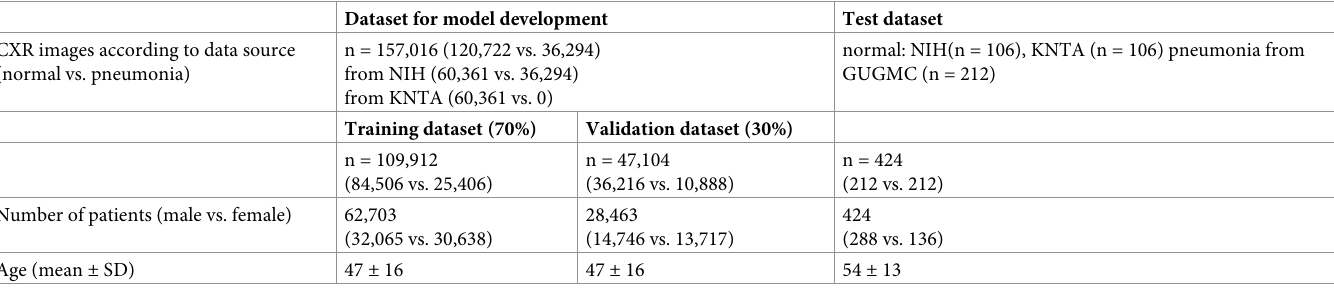
Table 1. Dataset for model development and